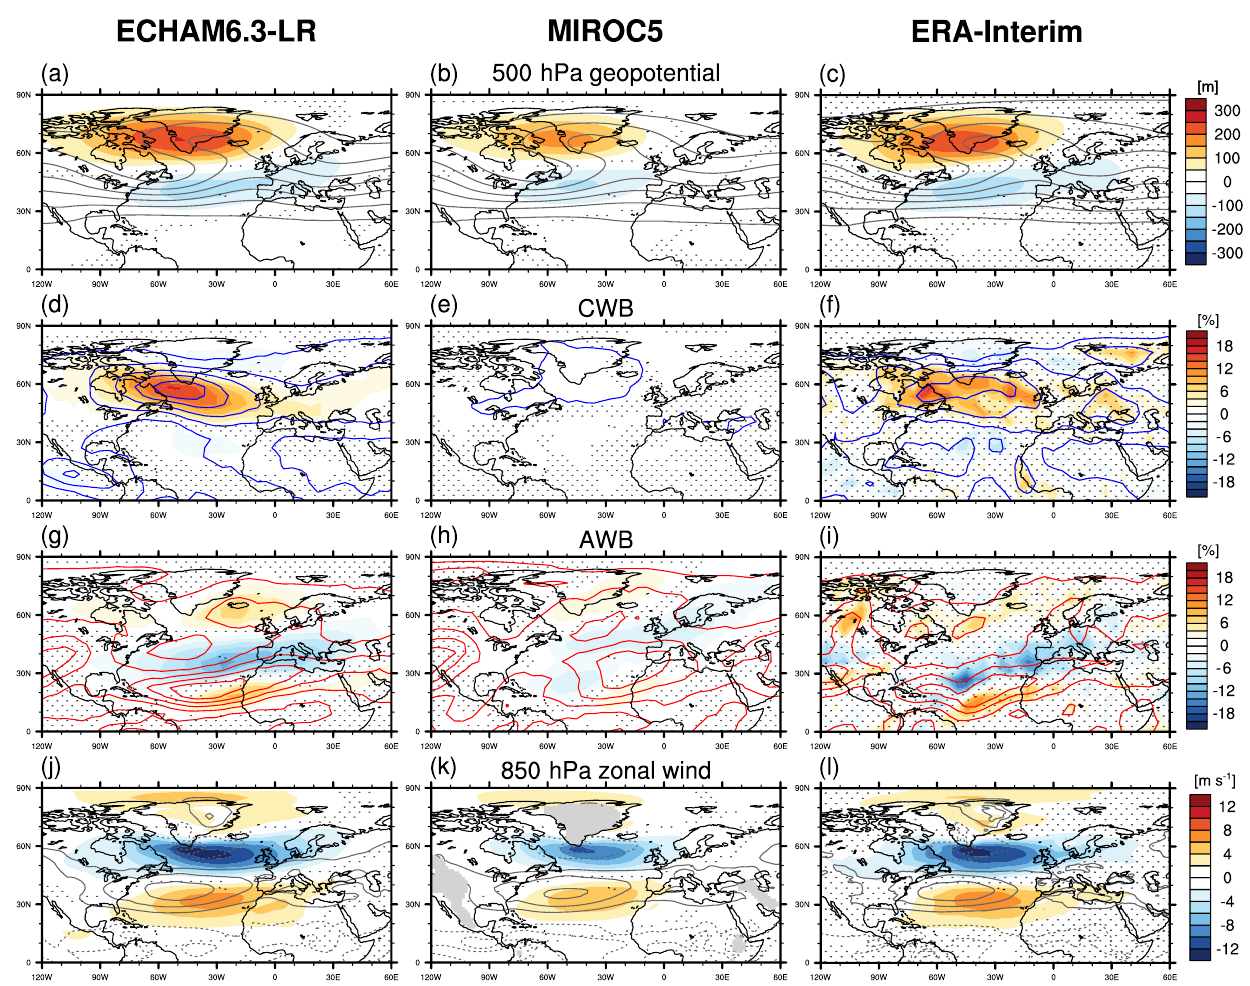
Figure 5. Ensemble means of the circulation anomalies during GB days for (left) ECHAM6.3-LR, (centre) MIROC5, and (right) ERA- Interim. (a, b, c) 500hPa geopotential (contours are drawn every 100m from 5000 to 6000m) and anomalies (shading, in m). (d, e, f) Cyclonic wave breaking frequency (first contour and interval: 5%) and anomalies (shading, in %). (g, h, i) Same as (d) , (e) , and (f) but for anticyclonic wave breaking frequency. (j, k, l) Zonal wind at 850hPa (first contour and interval: 4ms − 1 , zero contour omitted, and dashed contours for negative values) and anomalies (shading, in ms − 1 ). Anomalies are deviations from the 10-year DJF climatology, and only members with at least one blocked day are used for the composites. Dotted areas are not significant at the 10% level, with the significance calculated using a bootstrap method. For ERA-Interim, the AWB and CWB frequency fields (contours) have been smoothed for better